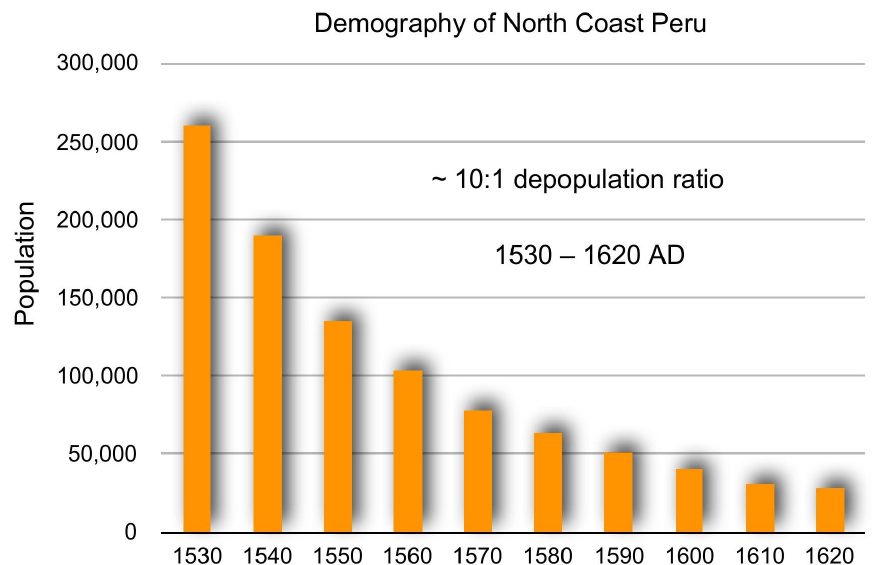
Figure 7. Depopulation on the north coast of Peru from the Spanish Conquest, 1532 AD to 1620 AD. (Figure prepared by Kirk A. Maasch from data in [42]).